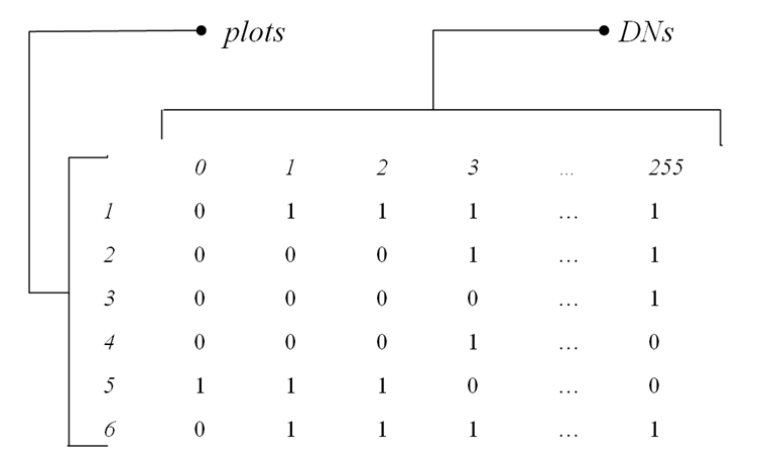
Figure 2. The presence/absence matrix M